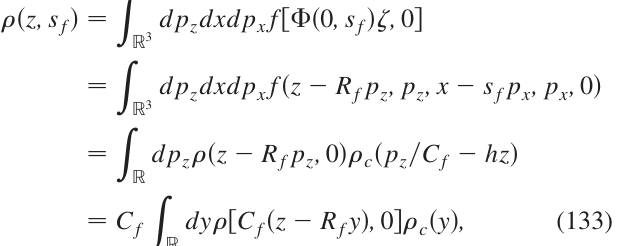
FIG. 4. (Color) Proposed layout of FERMI@Elettra first bunch compressor system. Accelerating rf cavities in red, quadrupole magnets in blue, drift sections in black, and dipoles in green. Chicane parameters are discussed in Table I.